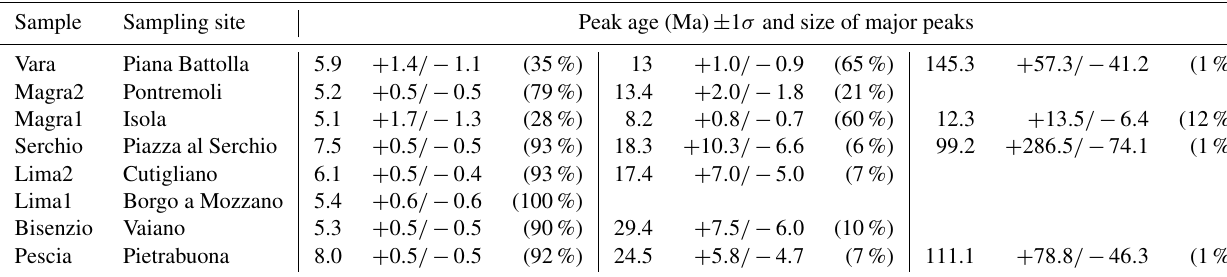
Table 3. Peak ages with standard error and size of major peaks (%). Sample Sampling